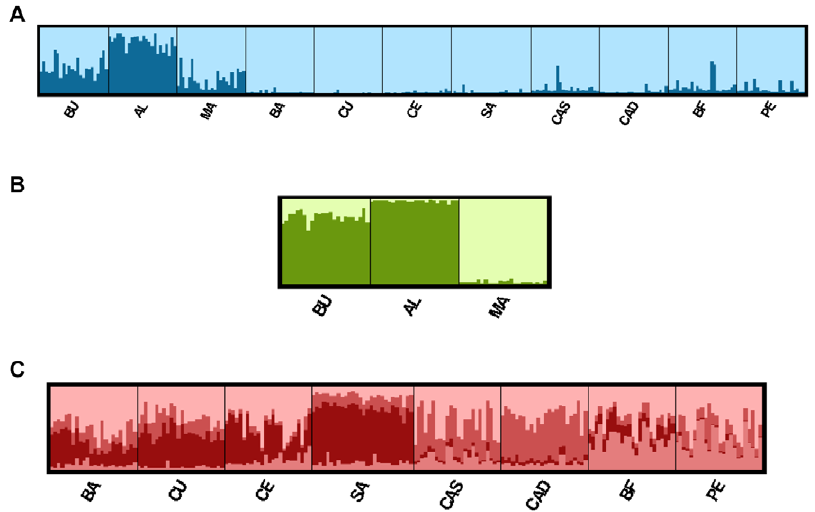
Figure 3. Population structure in native and introduced populations of Microcosmussquamiger with the most likely number of populations (K) inferred with the STRUCTURE programme. A) Including all populations, B) Native populations, and C) Introduced